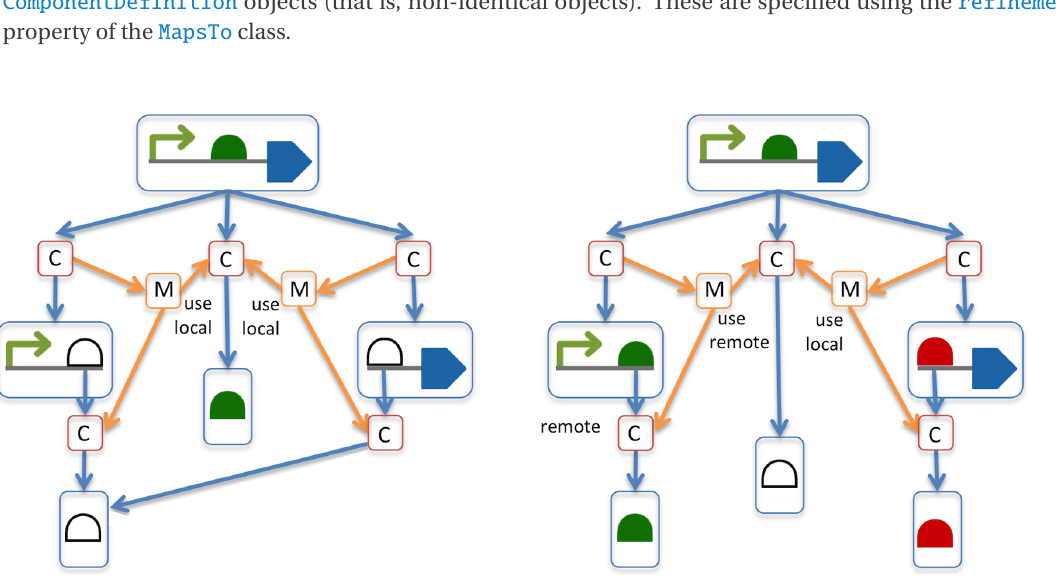
Figure 10: Linking Component objects using MapsTo entities. Boxes with diagrams represent ComponentDefinition objects, boxes with the C label represent Component objects, and boxes with the M label represent MapsTo objects.